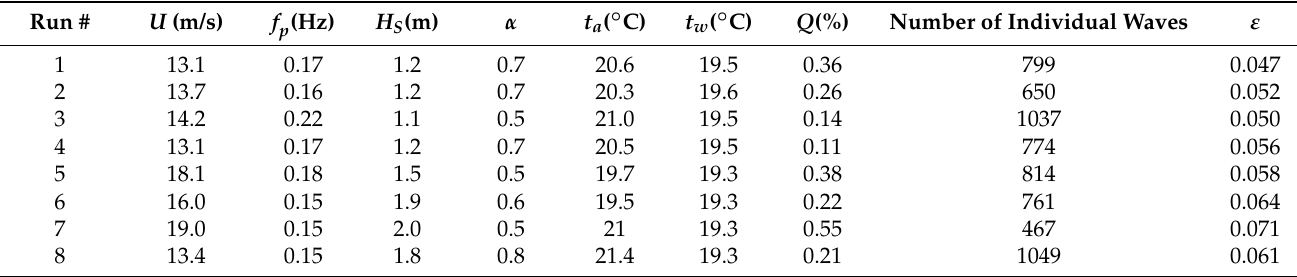
Table 1. Measurement